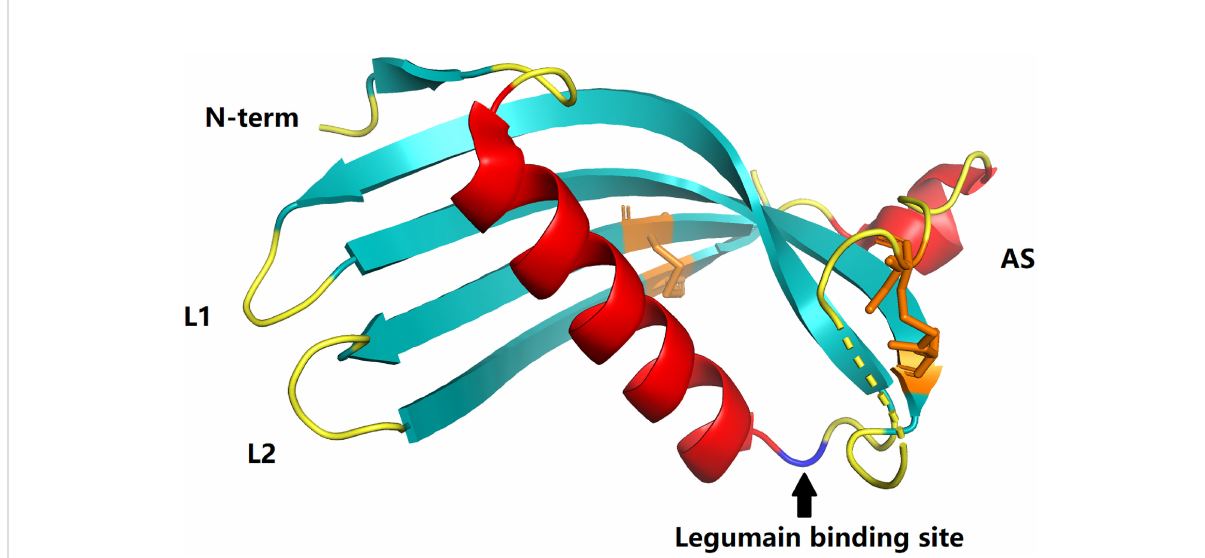
FIGURE 1 Crystal structures of cystatins C (PDB:3GAX). The papain-binding epitope is formed by the N-terminus, loop L1, and loop L2. The AS is an irregular appending structure at a ‘ back side ’ loop system harboring a potential legumain-binding site (blue). Disul fi de bonds in cystatin C are shown in